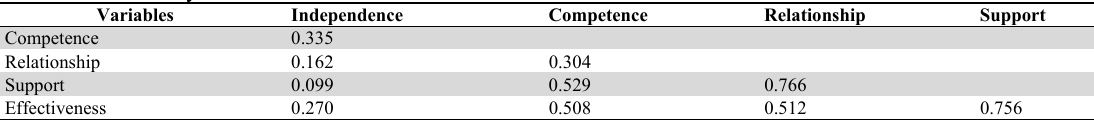
Discriminant Validity: HTMT Ratio